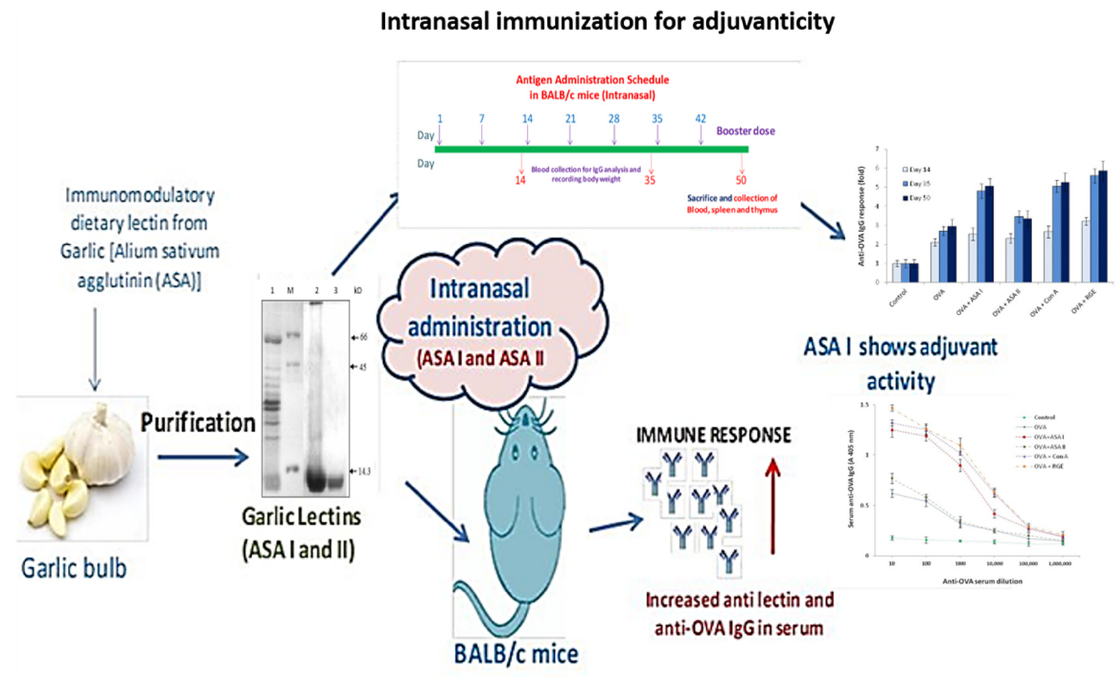
Figure 8. Illustration of the immune and adjuvant response of garlic lectins (ASA I and ASA II) on intradermal and intranasal administration in BALB/c mice. This explains the ability of garlic lectin, ASA I, as potential mucosal adjuvant for delivering and eliciting immune response against a weak antigen such as ovalbumin, through intranasal